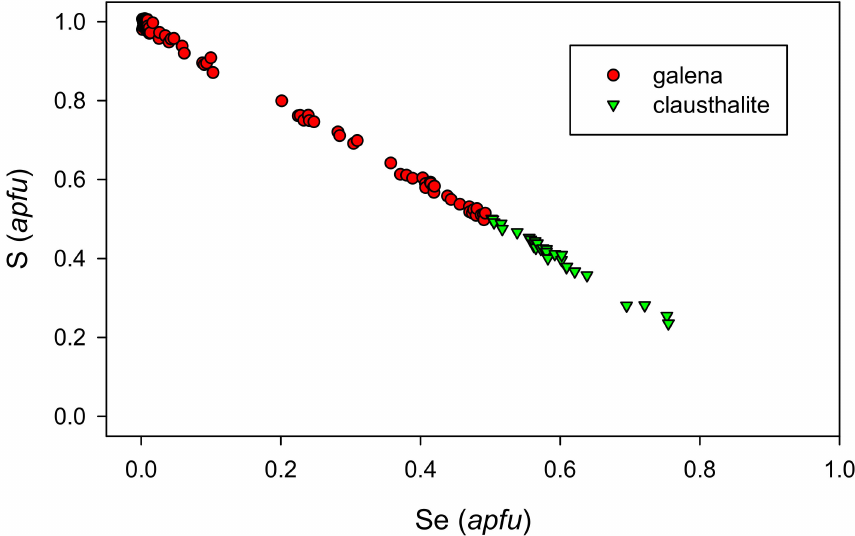
Figure 3. Graph of Se vs. S ( apfu ) for members of the clausthalite–galena series from the Kremnica